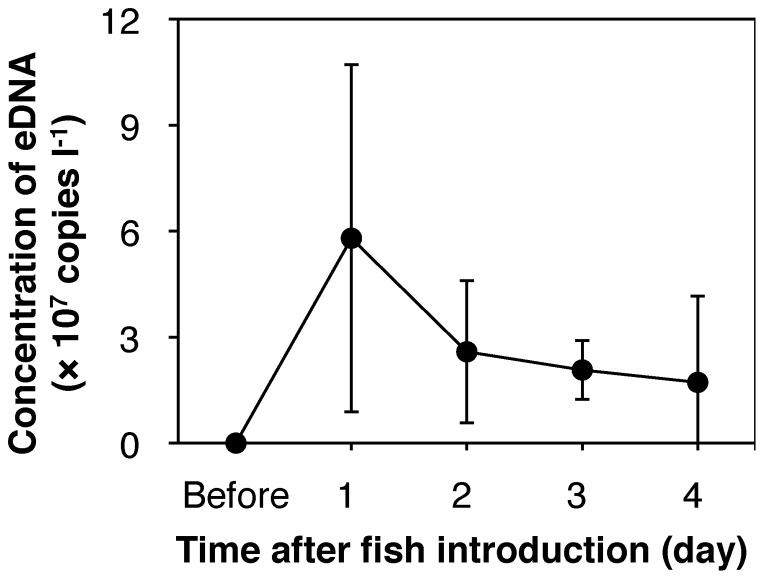
Time-dependent changes in the eDNA concentration after fish introduction.Plots and error bars indicate means and standard deviations of five individuals, respectively.